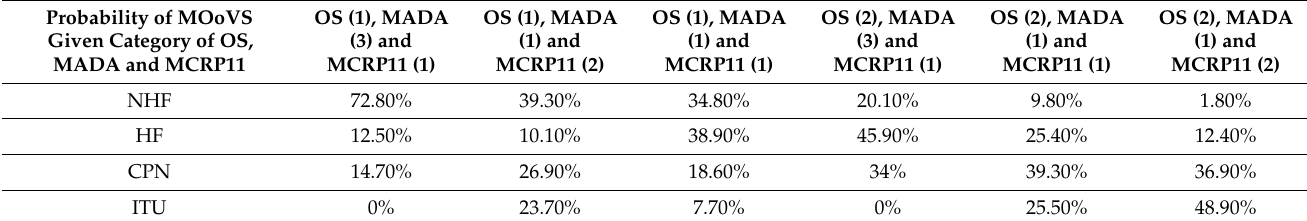
Table 9. The heat-mapped, conditional probabilities of MOoVS given the different configurations of MADA, OS and MCRP11.